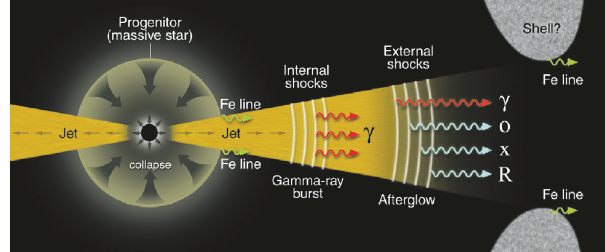
Figure 18: The death of a massive star produces a GRB (and its multiband AG) and an energetic and bright SN (from